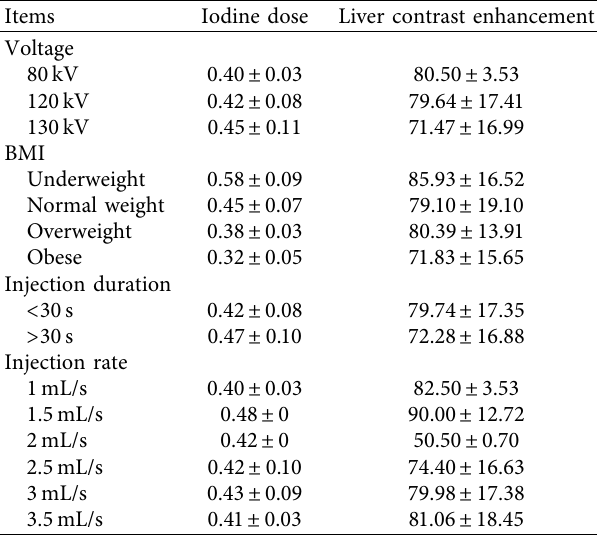
Table 4: Mean iodine dose and liver contrast enhancement according to the diferent parameters.